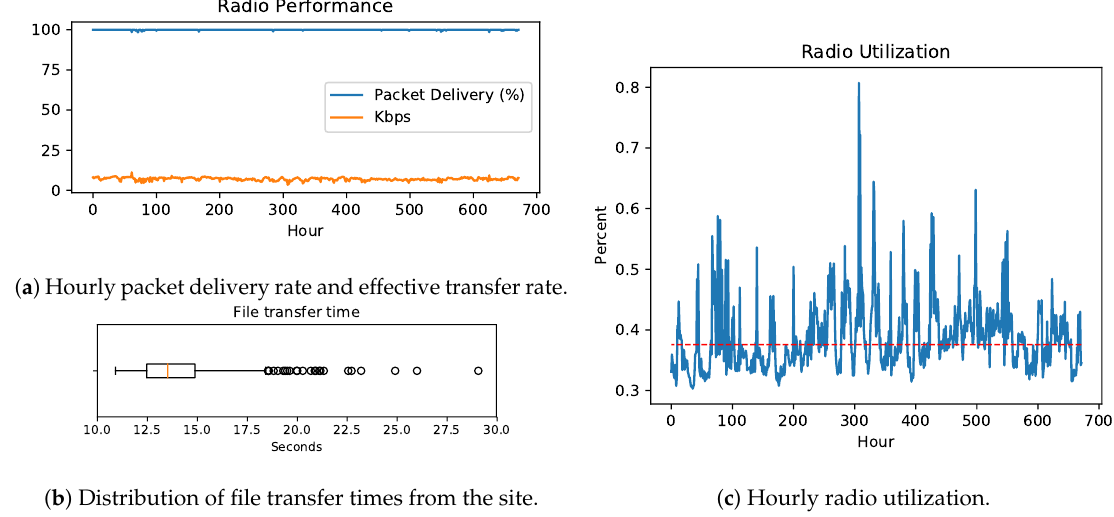
Figure 12. Radio performance measurements from the site from September